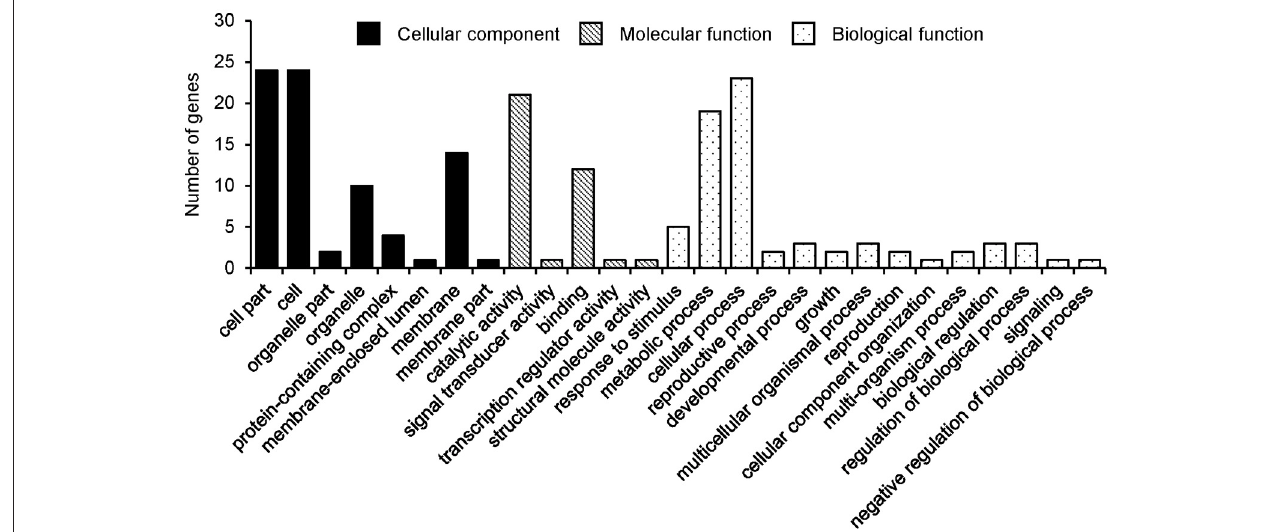
FIGURE 3 | Gene ontology classification of annotated genes for seed oil